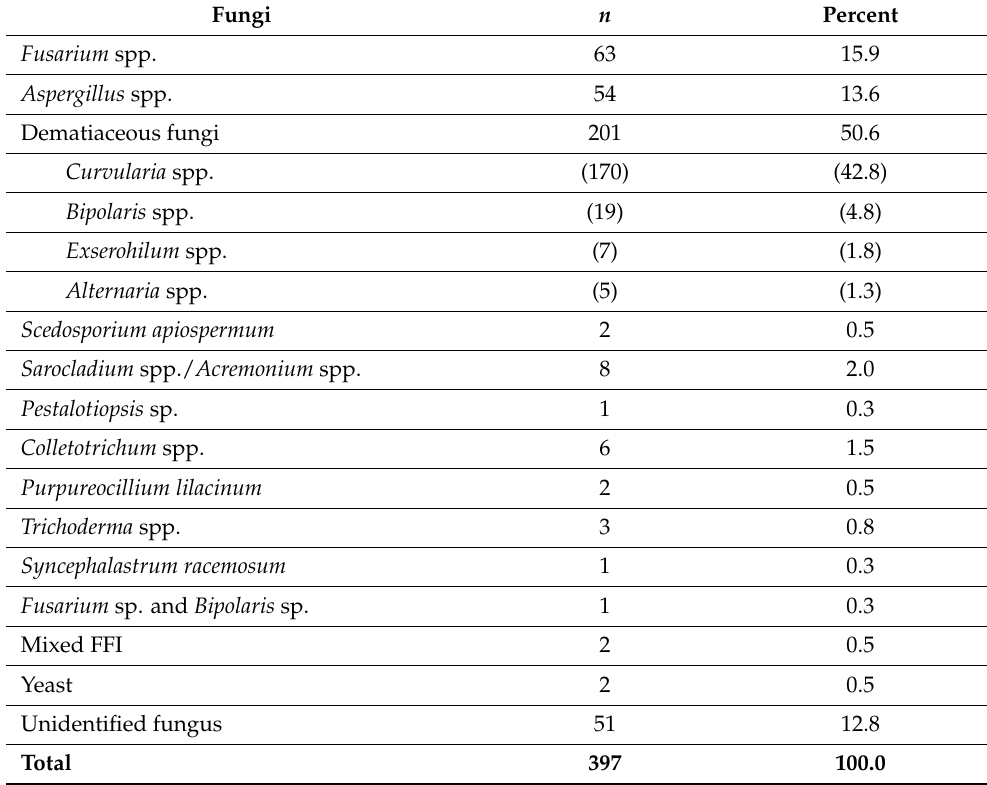
Table 4. Identification of fungi isolated from corneal samples of patients with microbial keratitis.